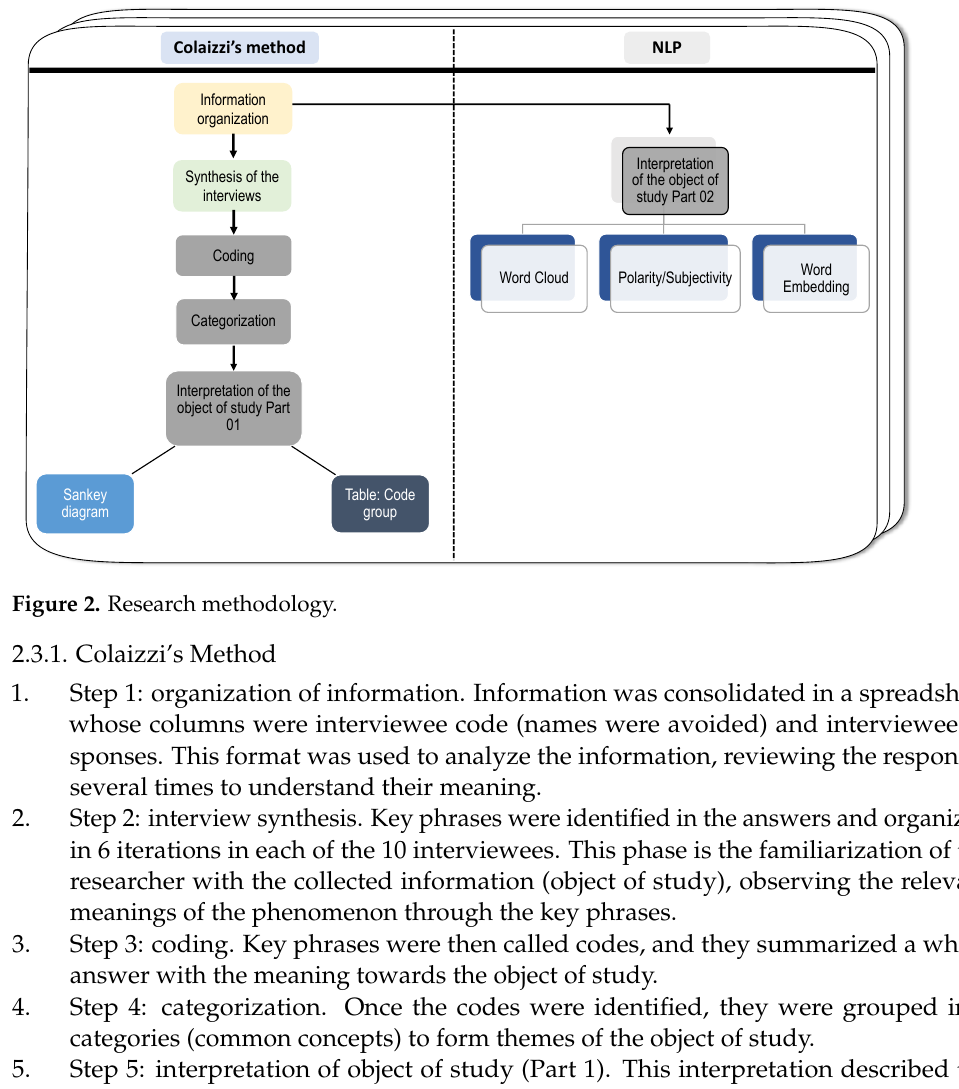
Table: Code groupSankey